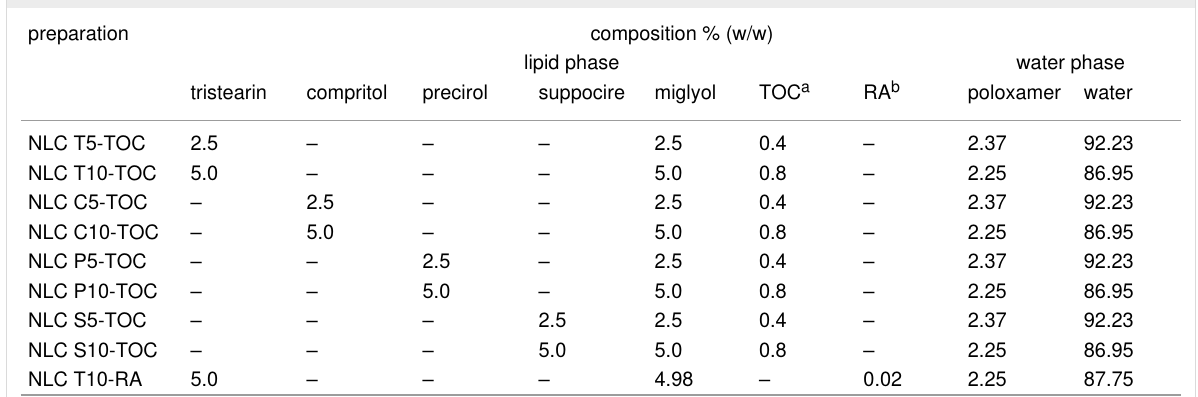
Table 3: Composition of antioxidant-containing NLCs.